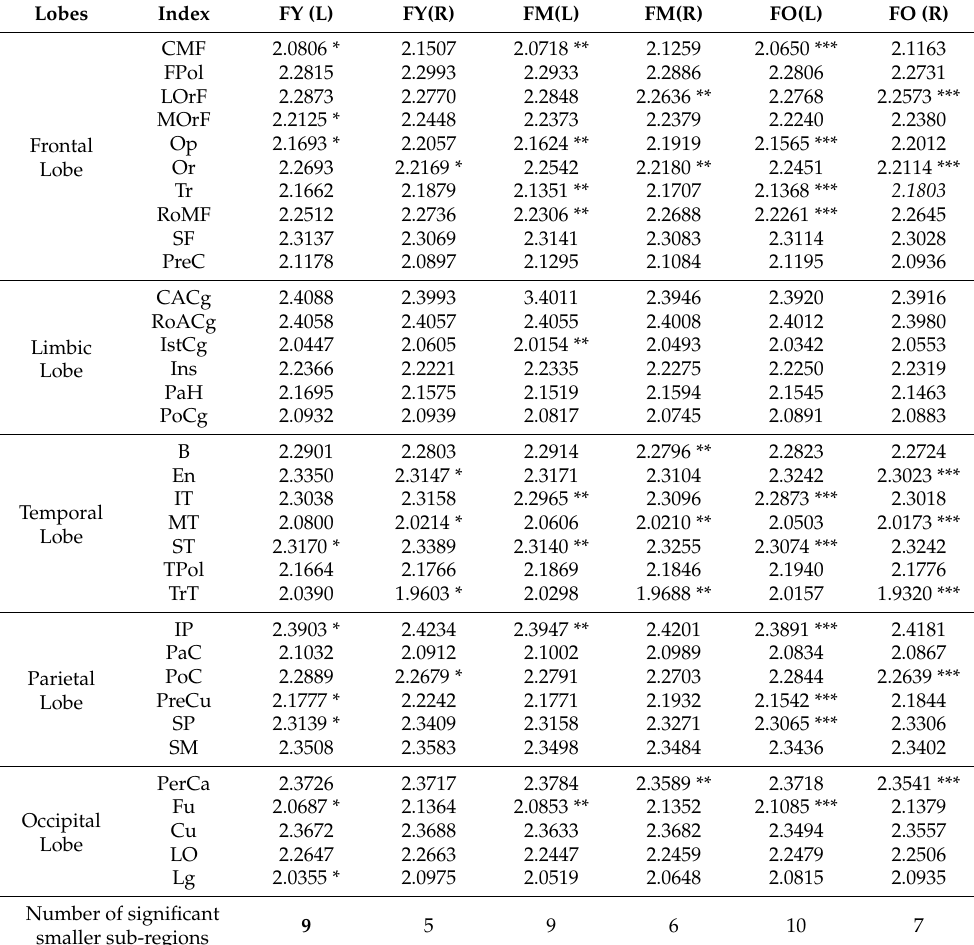
Table 3. Subregion fractal dimension (FD) values in women of different